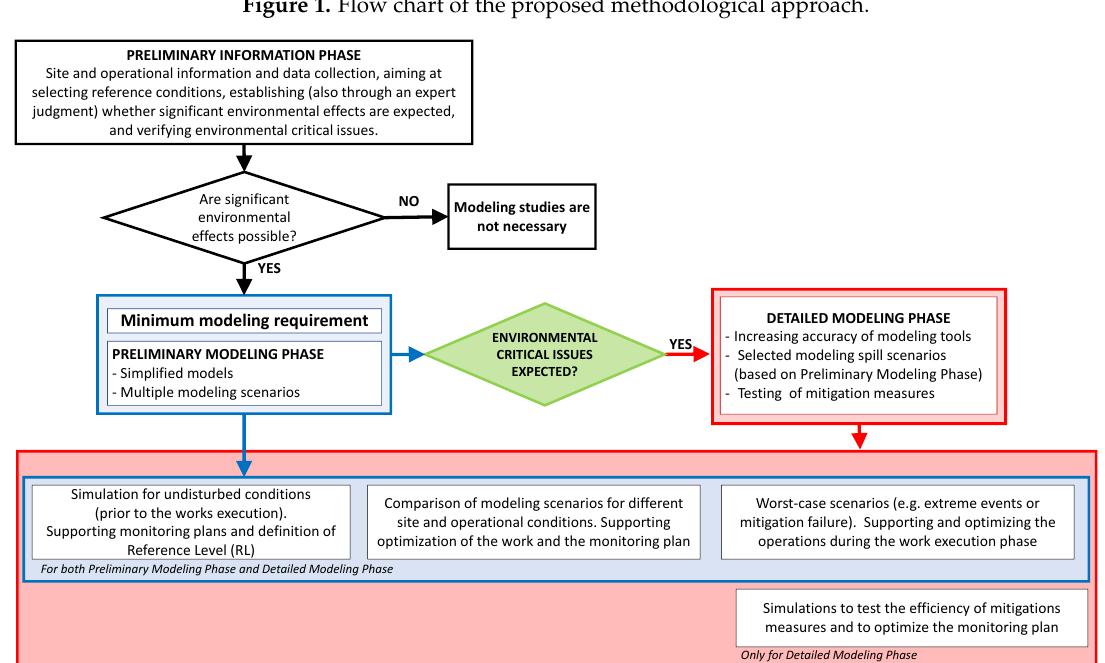
Figure 2. Flow chart of the different phases suggested for optimizing the modeling studies (thus the work plan and the related monitoring) to be performed with increasing level of detail during the different project